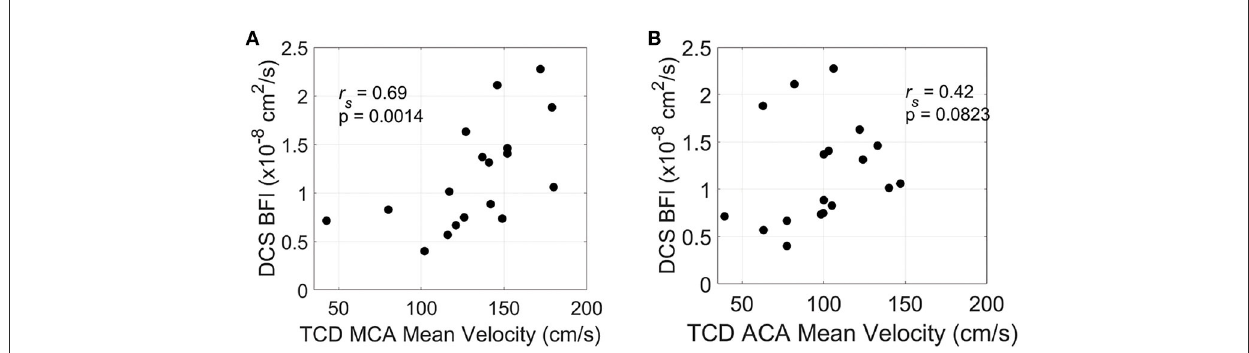
FIGURE4 Relationship between resting-state and pretreatment micro- and macrovascular blood flow. Mean blood flow velocity in the middle cerebral artery [MCA, (A) ] and anterior cerebral artery [ACA, (B) ] measured by transcranial Doppler ultrasound (TCD) on the hemisphere of DCS monitoring vs. diffuse correlation spectroscopy (DCS)-measured blood flow index (BFI). TCD and DCS data were both acquired prior to IT nicardipine